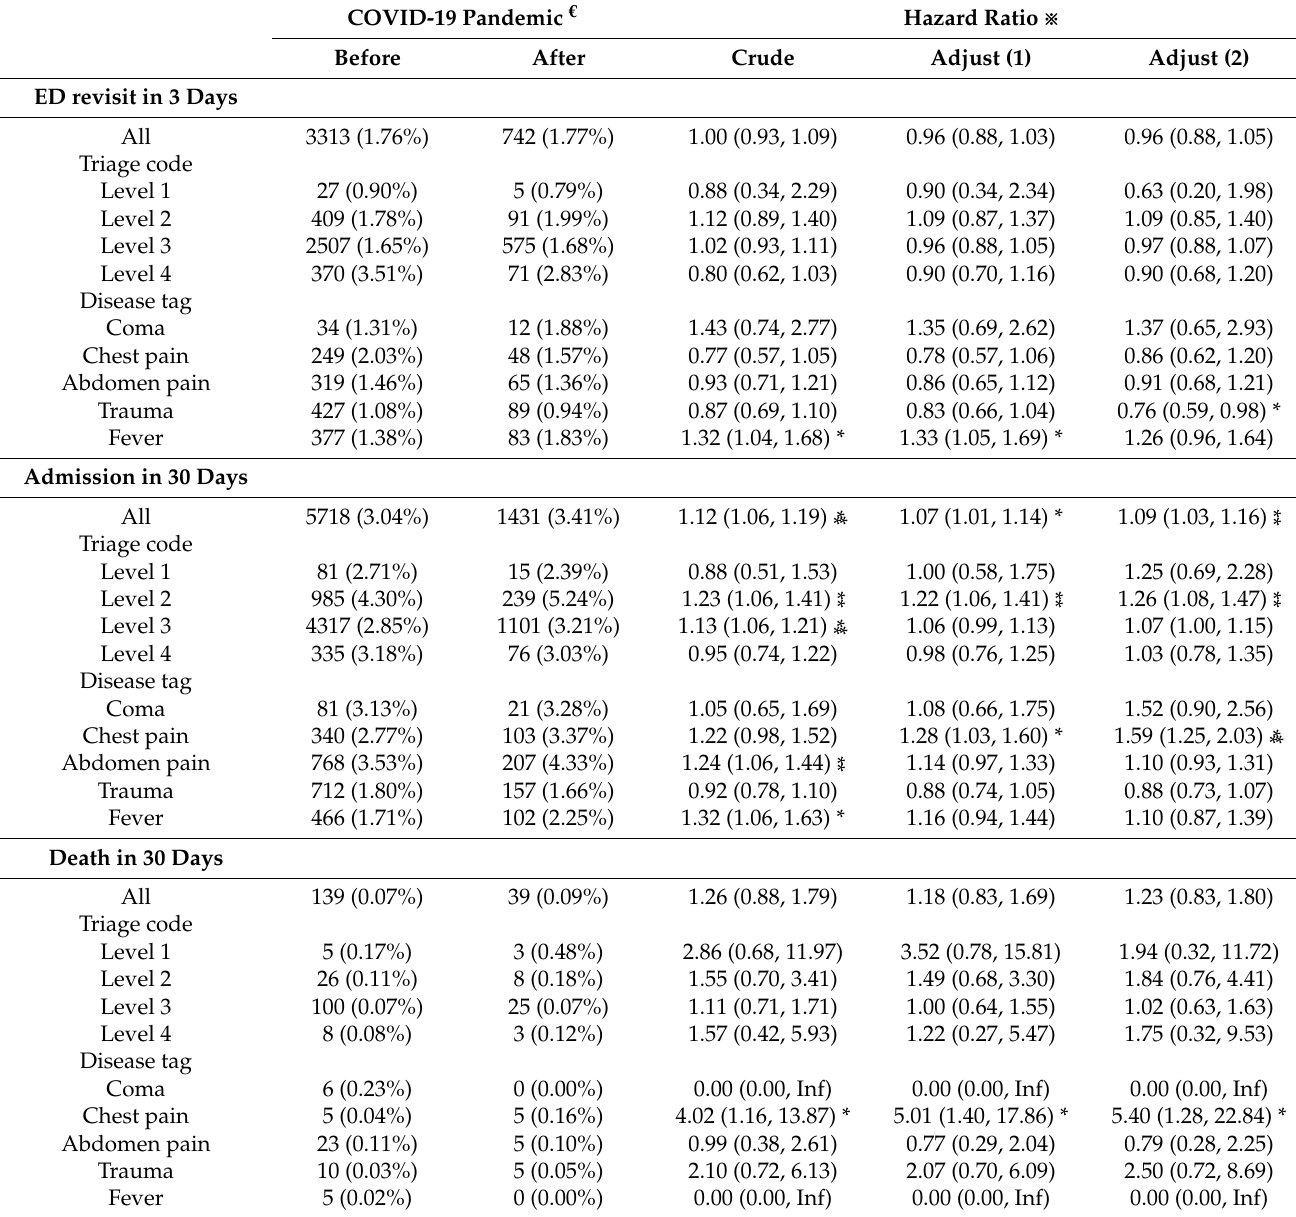
Table 7. Prognosis of non-admitted visits before and after the start of the COVID-19 pandemic. COVID-19 Pandemic € Hazard Ratio ※ Before After Crude Adjust (1) Adjust